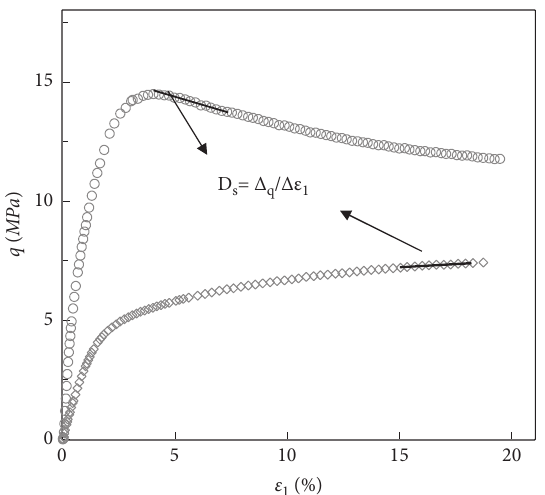
Figure 4: The schematic diagram for defining the strain-softening index.